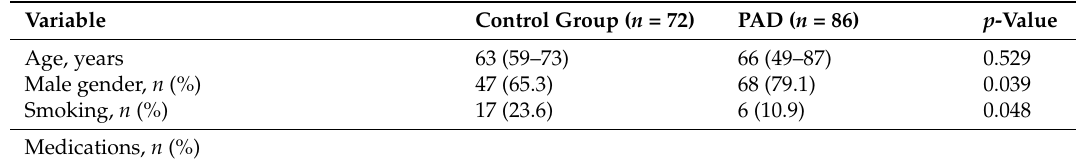
Table 1. Demographic, clinical, and biochemical characteristics of the control group and peripheral artery disease (PAD) patients.